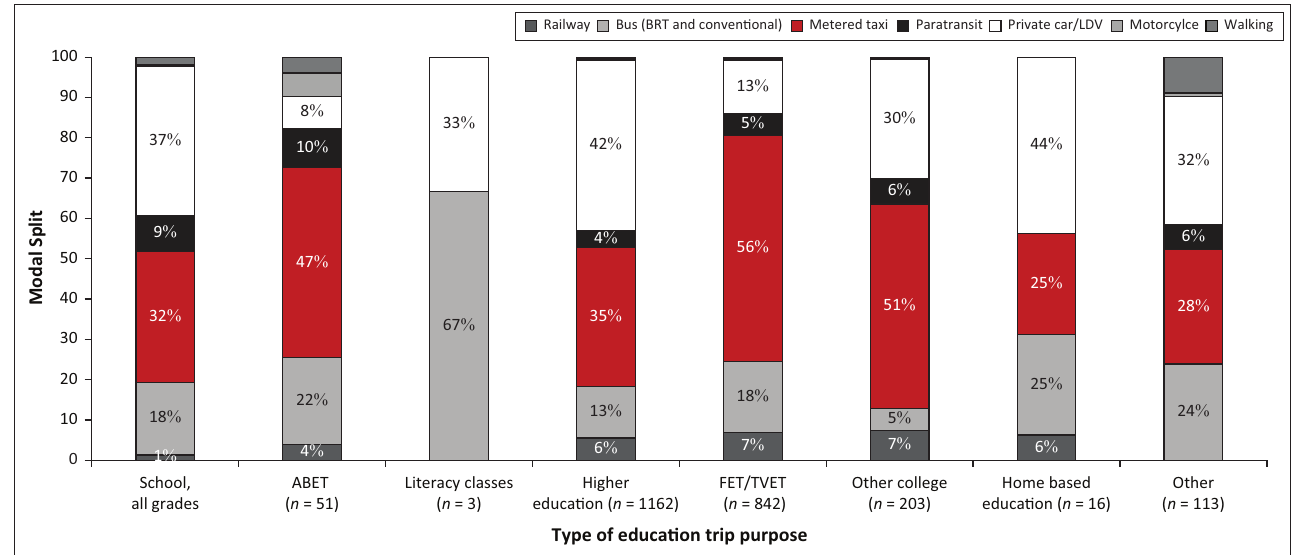
FIGURE 3: Modal split for education trips on a national level ( n = 12